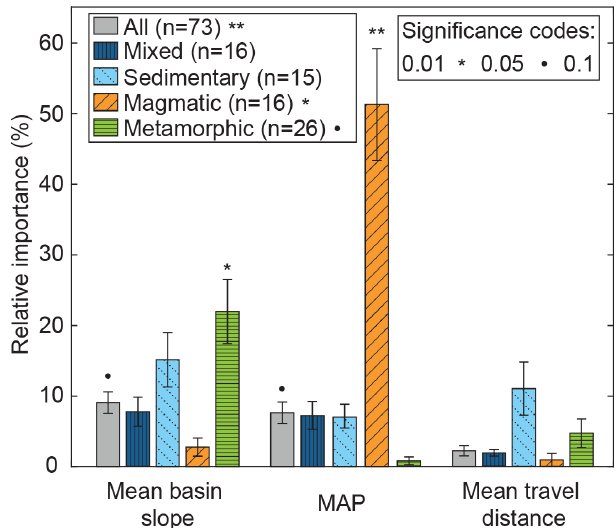
Figure 9. Relative importance of mean basin slope, MAP, and mean travel distance to the multivariate linear regression R 2 value. Re- sults are given for all lithologies combined (grey) and differentiated by lithology (colours). Multivariate linear regression results are pro- vided in Table